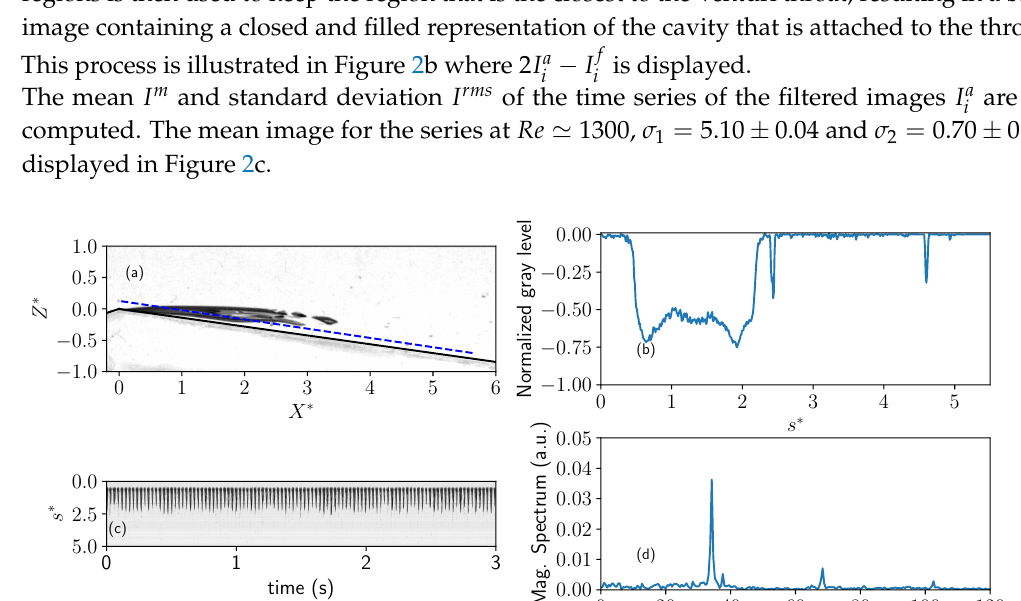
at Re = 1600, σ 1 = 4.97 0.04 and i ±